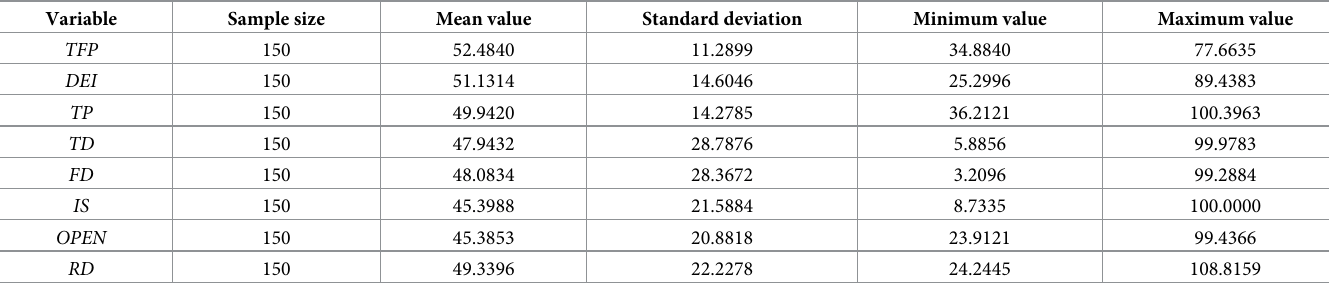
Table 5. Statistical description of standardized